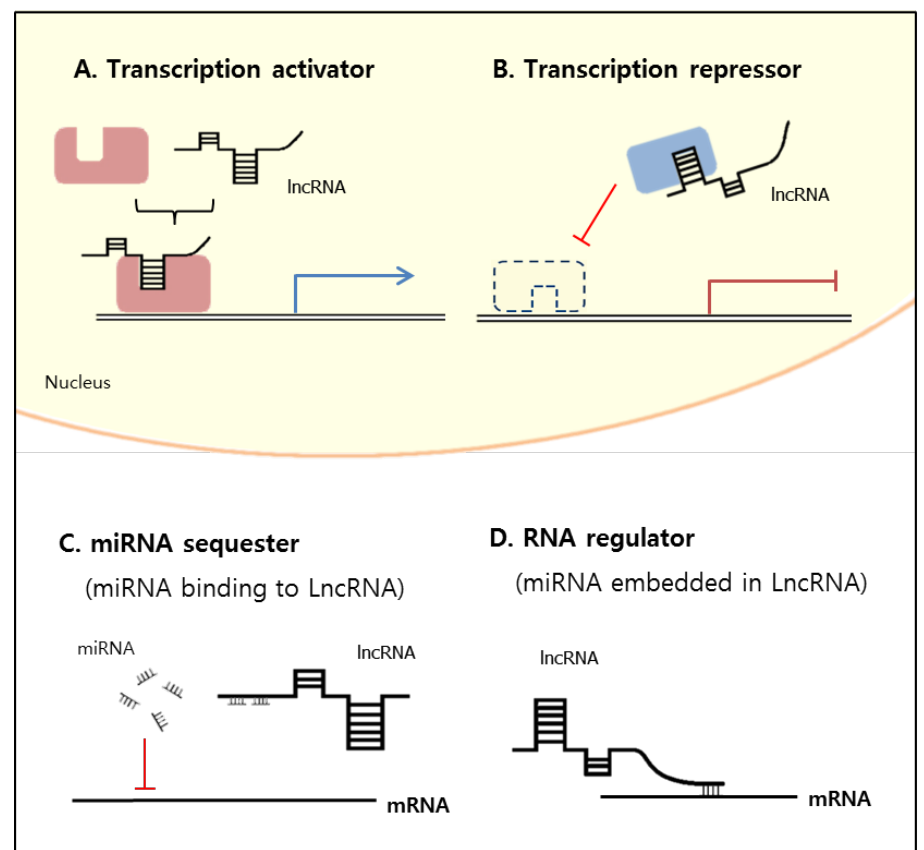
Figure 1. Long noncoding RNA (lncRNA) functions at nucleus and cytoplasm. ( A ) Transcription activator involved in gene expression and transcription regulation in nucleus; ( B ) transcription repressor inhibits gene expression by occupying DNA binding site in nucleus; ( C ) miRNA sequester can function as miRNA decoy to sequester miRNAs from their mRNA targets; ( D ) RNA regulator decreases mRNA expression as RNA regulator in cytoplasm.